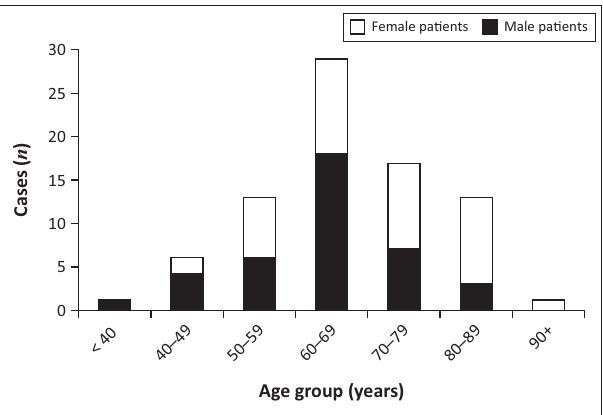
FIGURE 2: Distribution of chronic lymphocytic leukaemia cases by age group and gender,